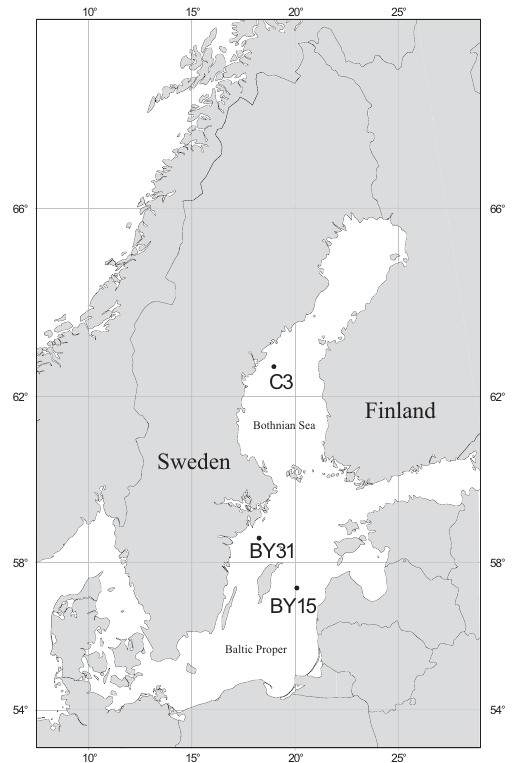
Fig. 2. Map of the sampling